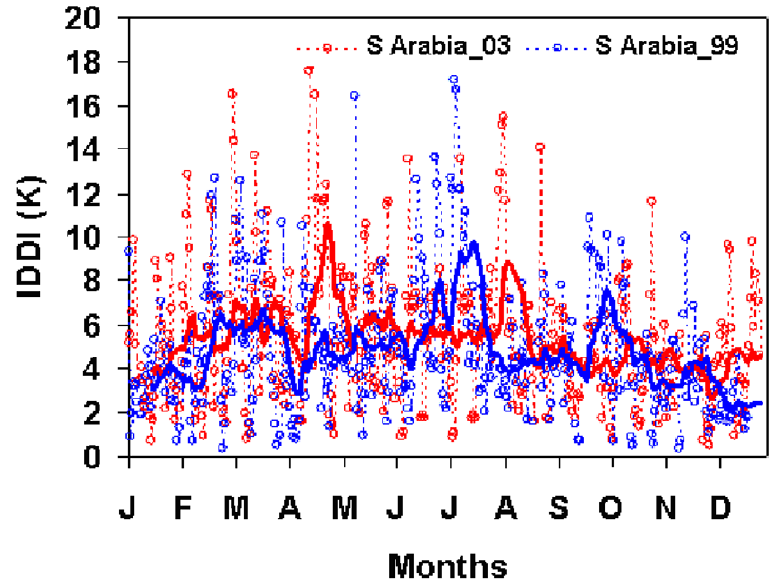
Fig. 20. Temporal Variation of IDDI (K) (dashed lines) for 1999 (blue) and 2003 (red) over the Saudi Arabian Desert (53 ◦ N–58 ◦ N and 19 ◦ E–24 ◦ E). The solid lines represent a 15-day running